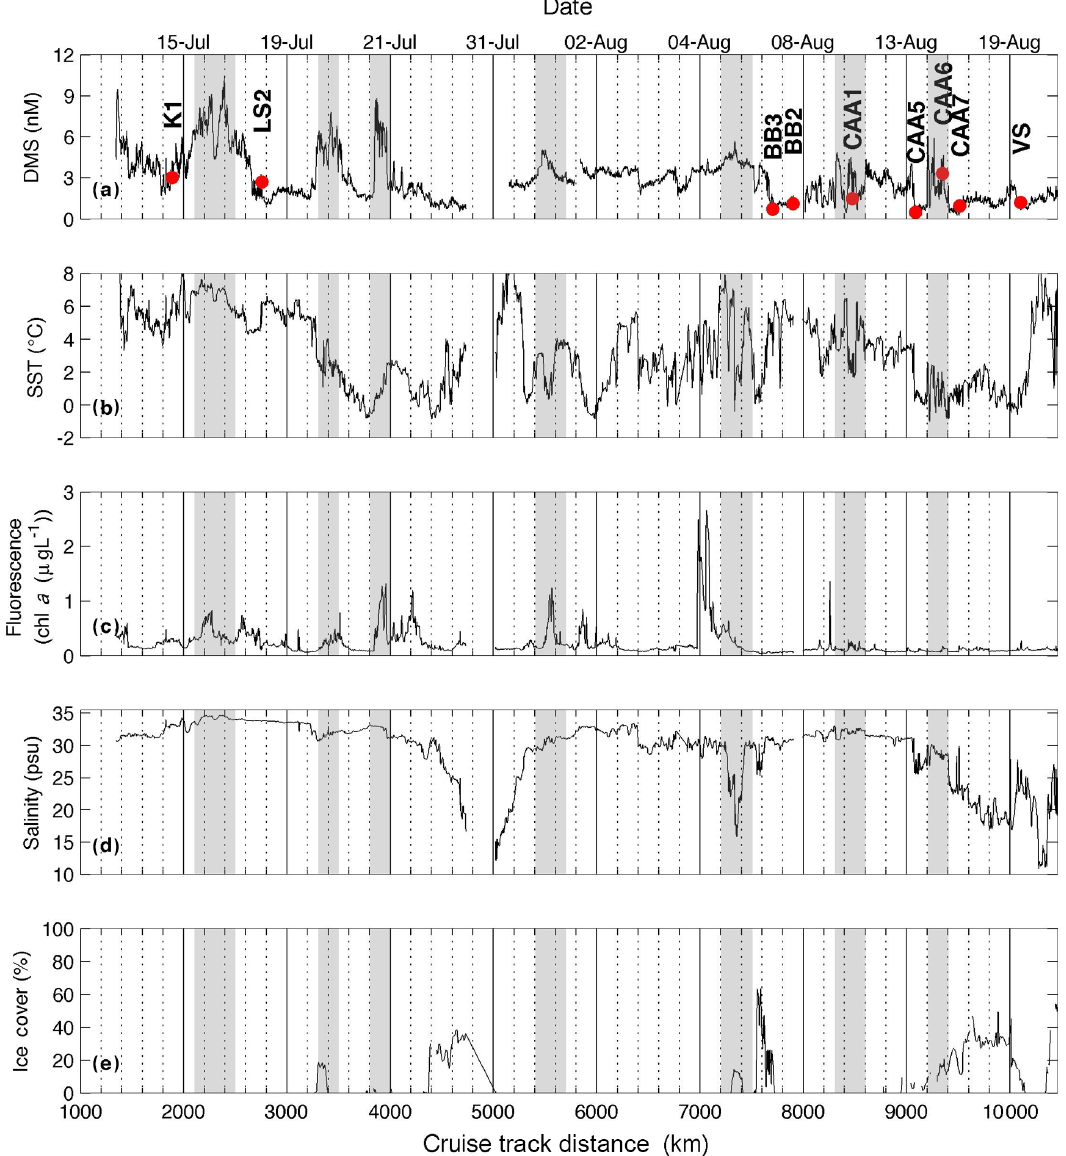
Figure 2. Distribution of DMS and hydrographic variables along our cruise track. Grey shaded areas denote regions of sharp increases in DMS. Labelled red dots indicate sampling stations (see Table